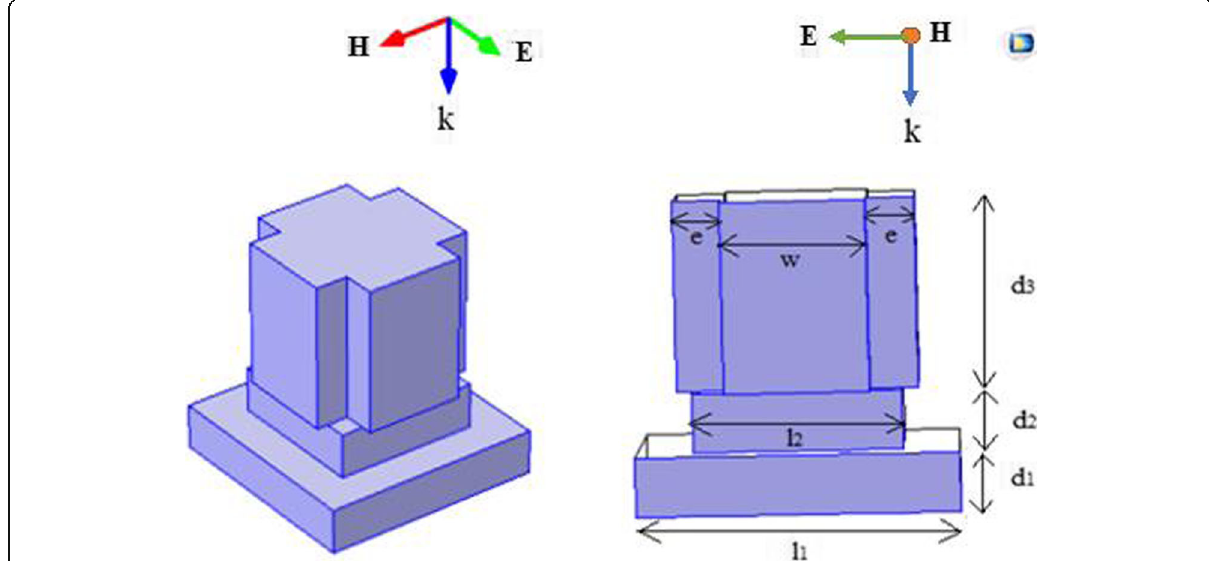
Fig. 1 Designed unit cell radar-absorbing metamaterial with three-layer cross-block structure. a Model of periodic unit. b Model size. l 1 = 4.0 mm, l